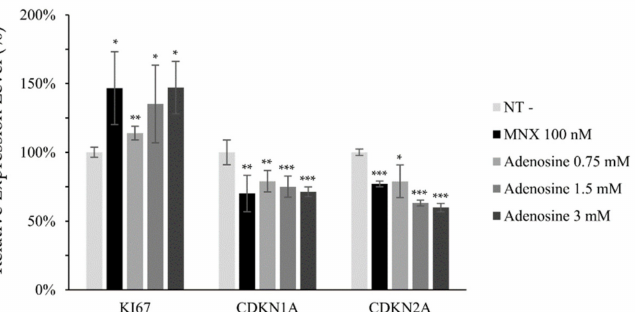
Figure 3. Adenosine modulated the mRNA expression of cell proliferation and cell cycle related genes in human dermal papilla cells. The mRNA expression level of cell proliferation marker (Ki67) and cell cycle arresters (CDKN1A and CDKN2A) was evaluated in hDPCs by RT-PCR after adenosine treatment for 24 h. Minoxidil was used as a positive control. The data represent the means of five independent samples. MNX, minoxidil; N.T, non-treated control; Significantly different compared with N.T (* p < 0.05, ** p < 0.01, *** p <